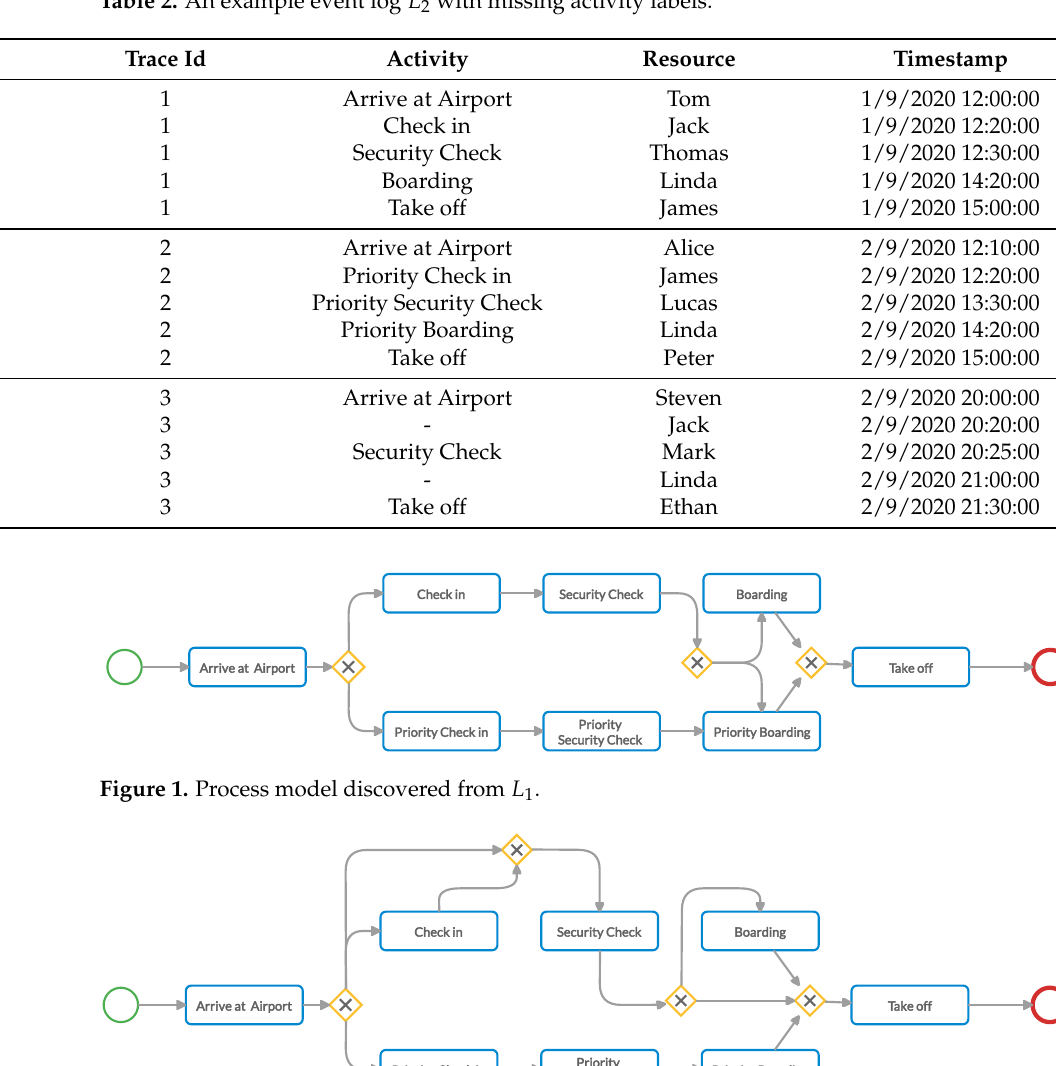
Table 2. An example event log L 2 with missing activity labels.